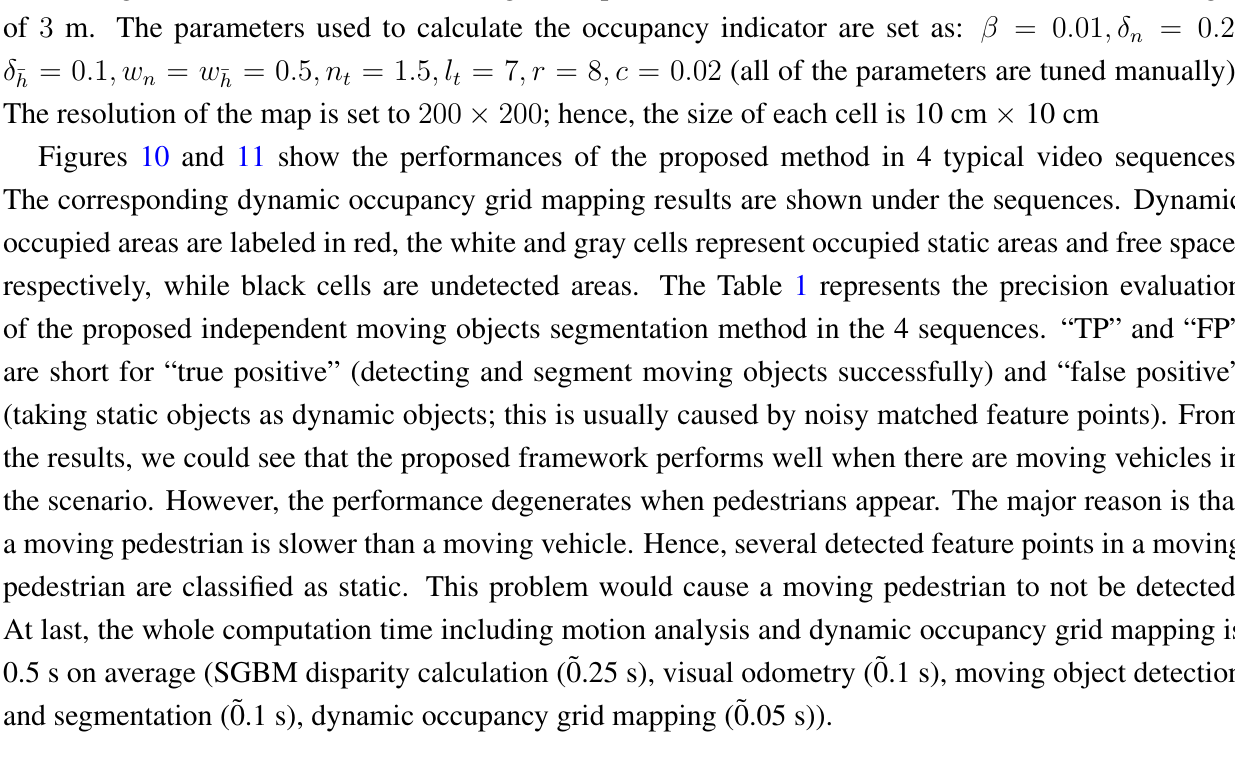
Figure 10. Experimental results of the dynamic occupancy grid map: independent moving objects (red), static occluded areas (white), free areas (gray) and undetected areas